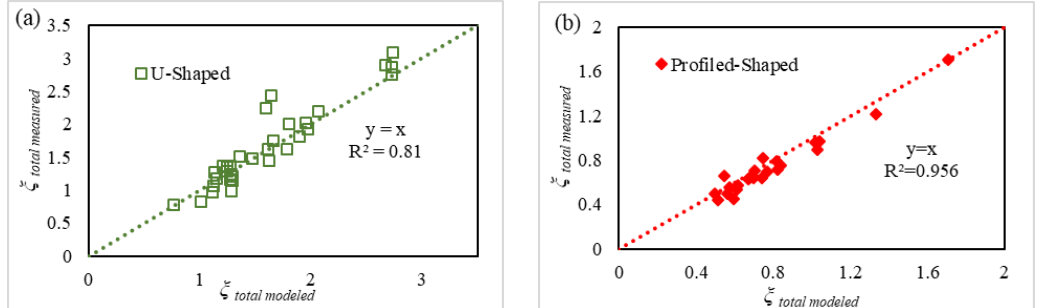
Figure 11. Linear regression between the measured ξ measured and modeled ξ modeled head loss coefficients for ( a ) the U-shaped support and ( b ) the profiled shape